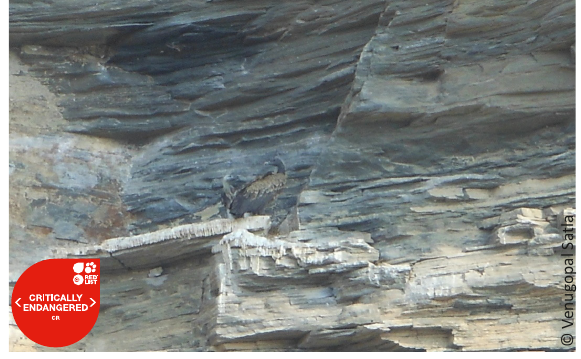
Image 3. Nest 1 of the Long-billed Vulture on Rapugutta.